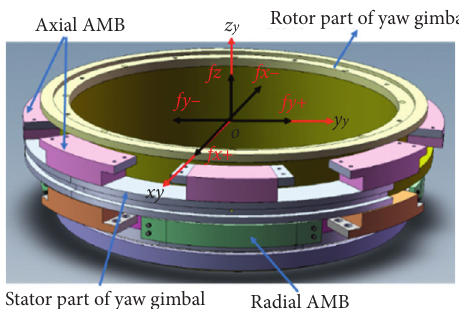
Figure 8: Force analysis of the yaw gimbal with an AMB